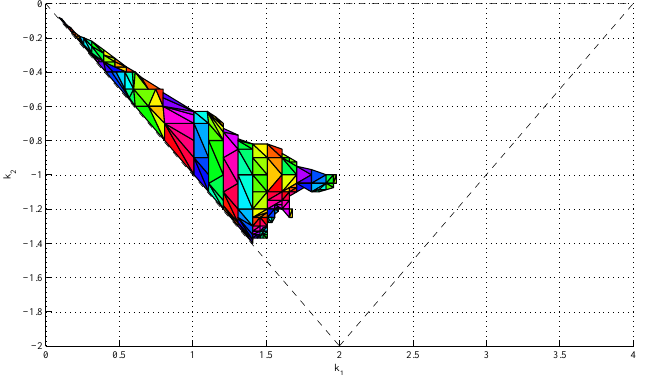
Figure 1: Stable area in ( k 1 , k 2 ) space found using pro- posed LMI